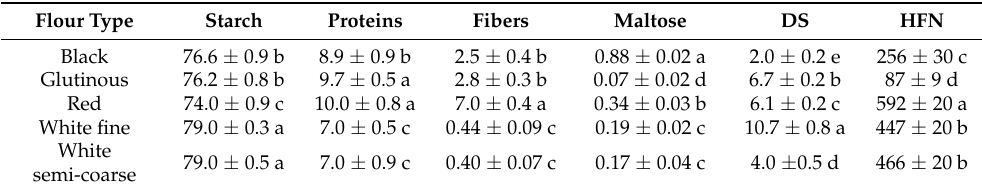
Table 1. Content of starch, proteins, fibers, sugars, and damaged starch (DS) in tested flours in g/100 g, Hagberg falling number (HFN) in s 1